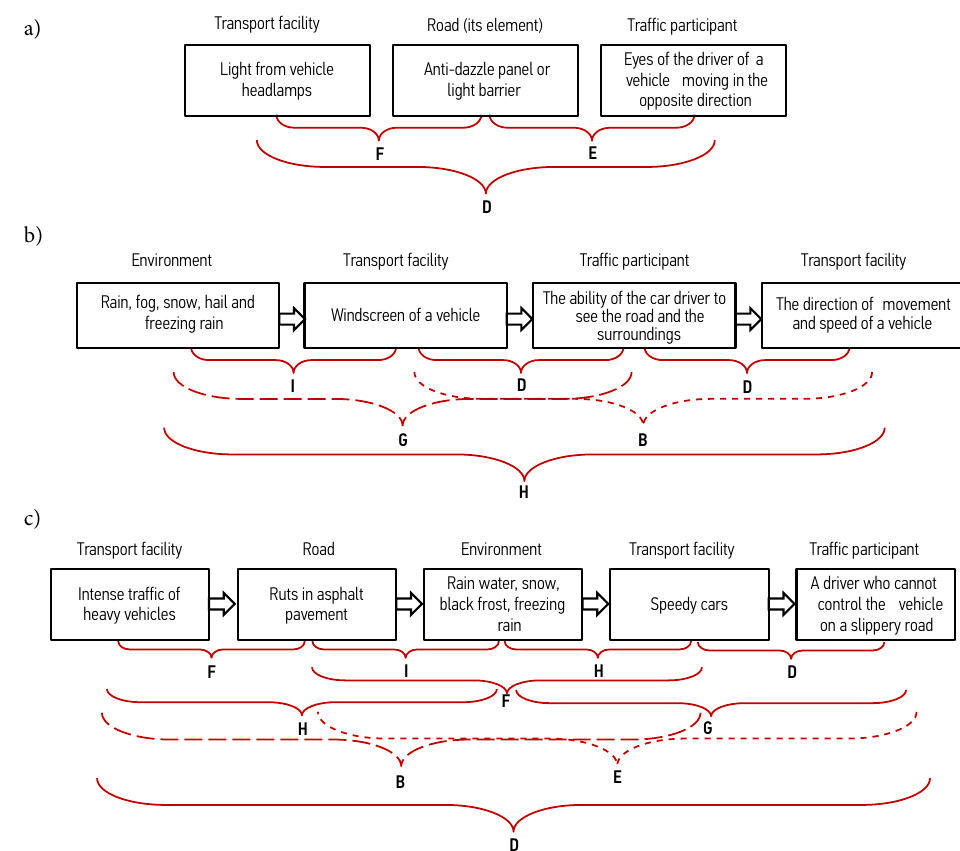
Fig. 2. The examples of the interaction between the elements of the TS and one (a), two (b) and three (c) intermediate